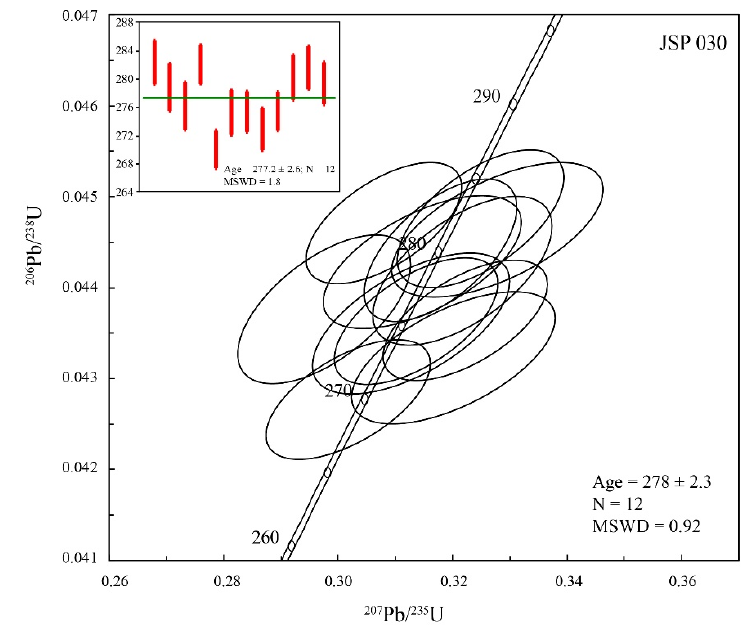
Figure 6. U–Pb Concordia diagram of zircon from the post-ore granite (JSP030).